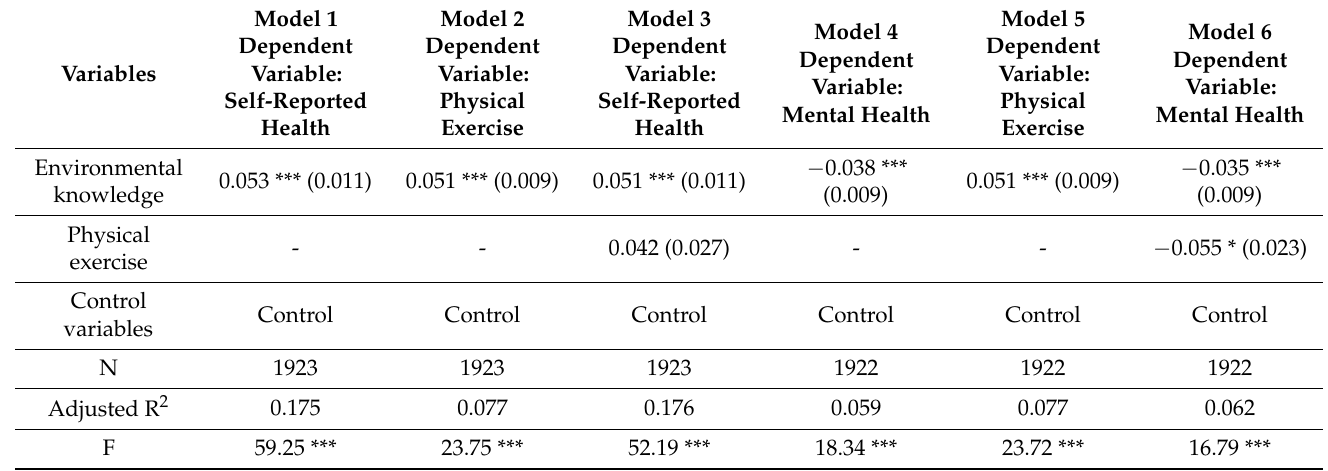
Table 5. Mediation test of physical exercise on EK and women’s physical and mental health.